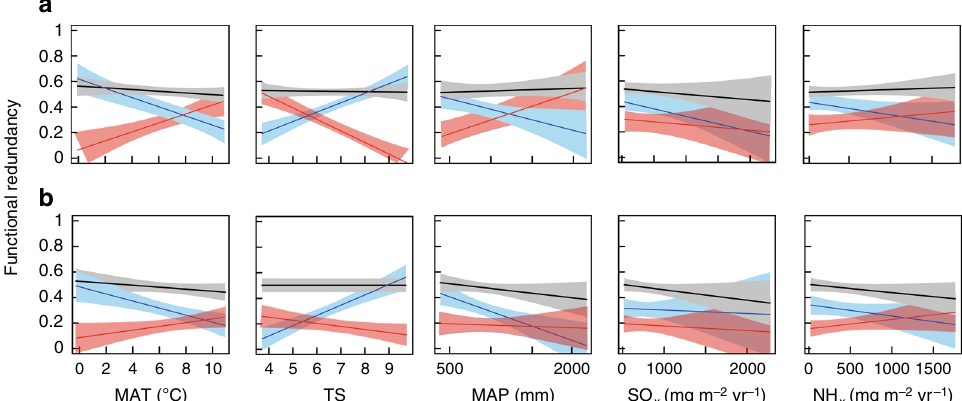
Fig. 5 Relationships between the major environmental variables and functional redundancy. Relationships for the vascular plant community a and bryophyte community b . Black lines represent the whole plant community (black), while the coloured lines represent the plant species in the two co- response clusters (blue = cluster I, red = cluster II). MAT = mean annual temperature (°C), TS = seasonality in temperature (°C), MAP = mean annual precipitation (mm), SO x = total sulphur deposition (mg m − 2 yr − 1 ), NH x = total reduced nitrogen deposition (mg m − 2 yr − 1 ). Linear regression models